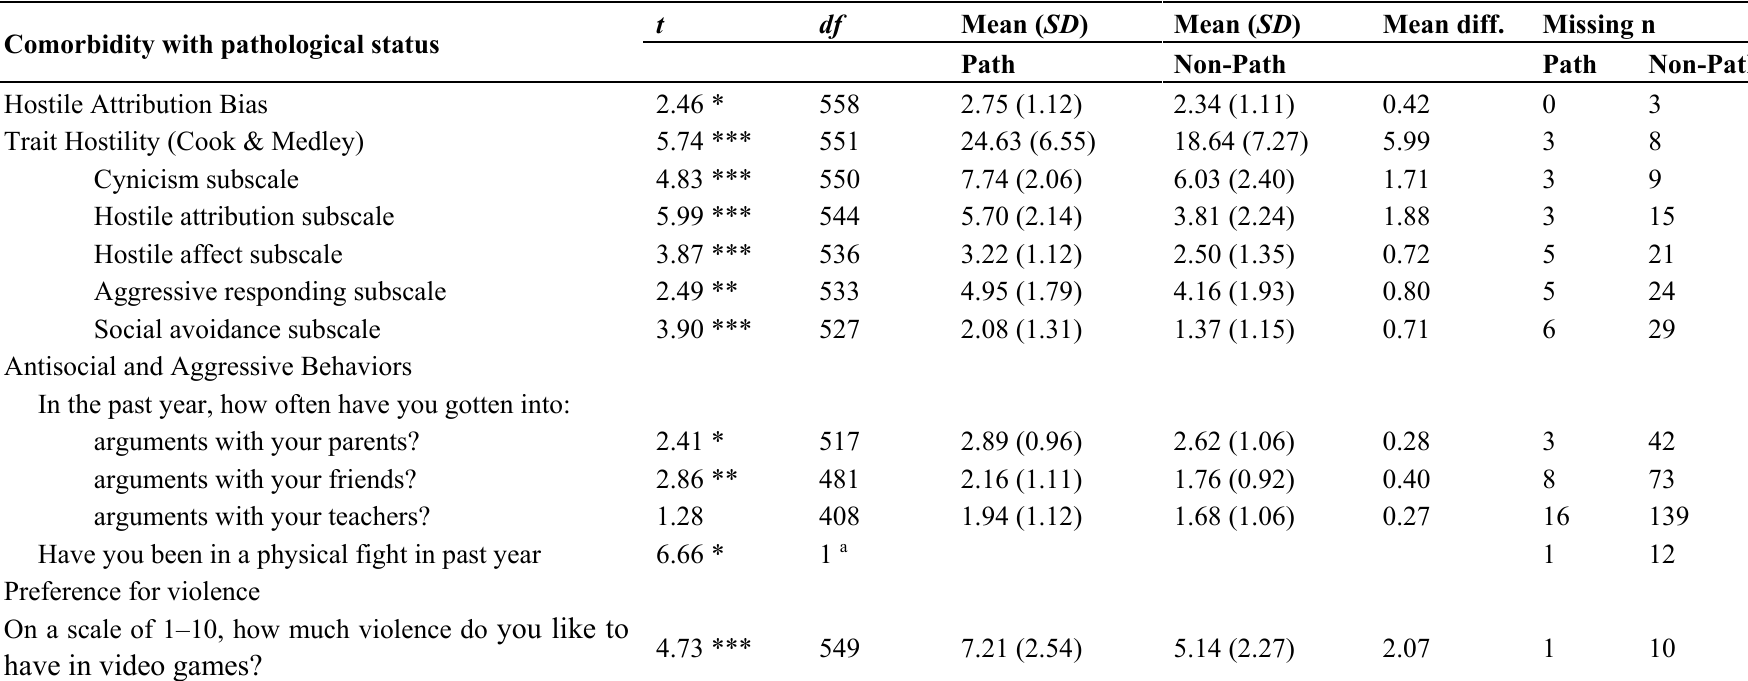
Table 2. Differences between pathological gamers vs. non-pathological gamers (Study 1: Young adolescents). t df Mean ( SD ) Mean ( SD ) Mean diff. Missing n Comorbidity with pathological status Path Non-Path Path